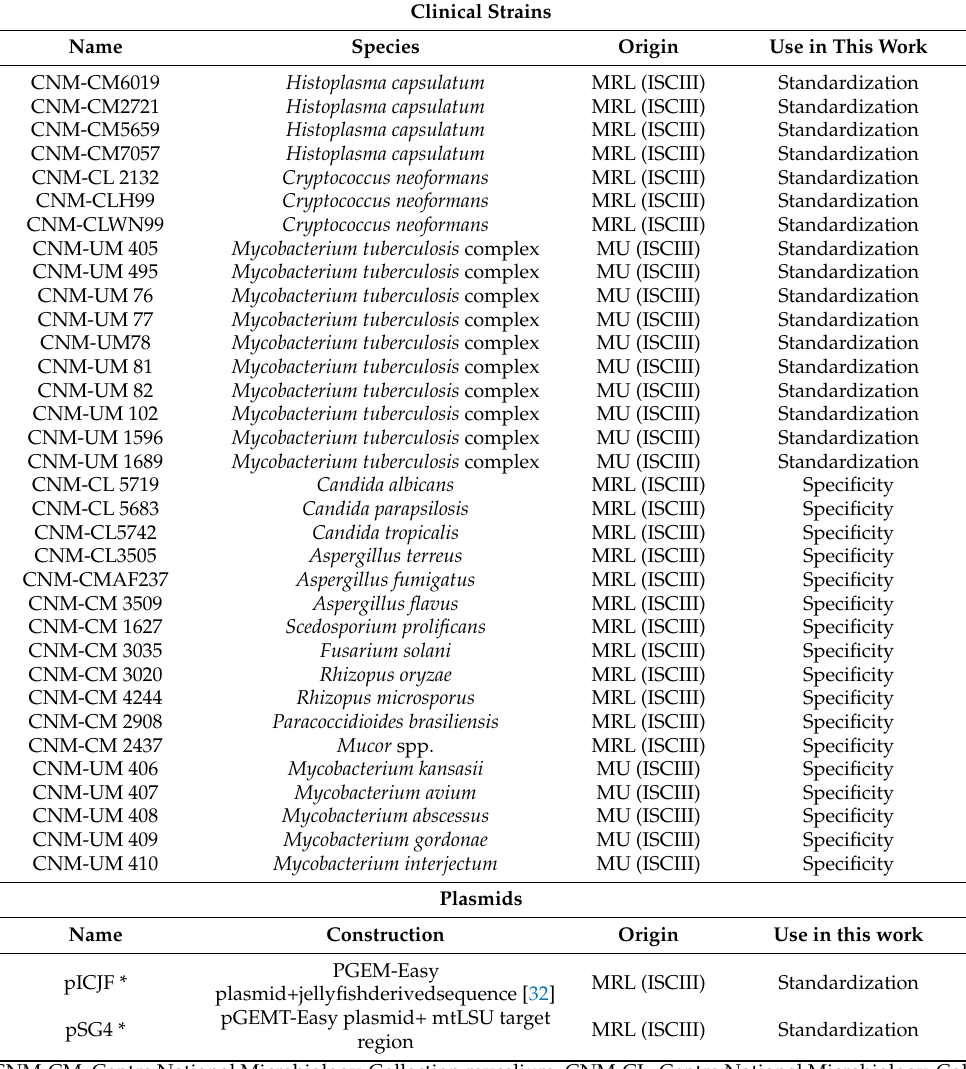
Table 1. Clinical strains and plasmids used for the standardization of the